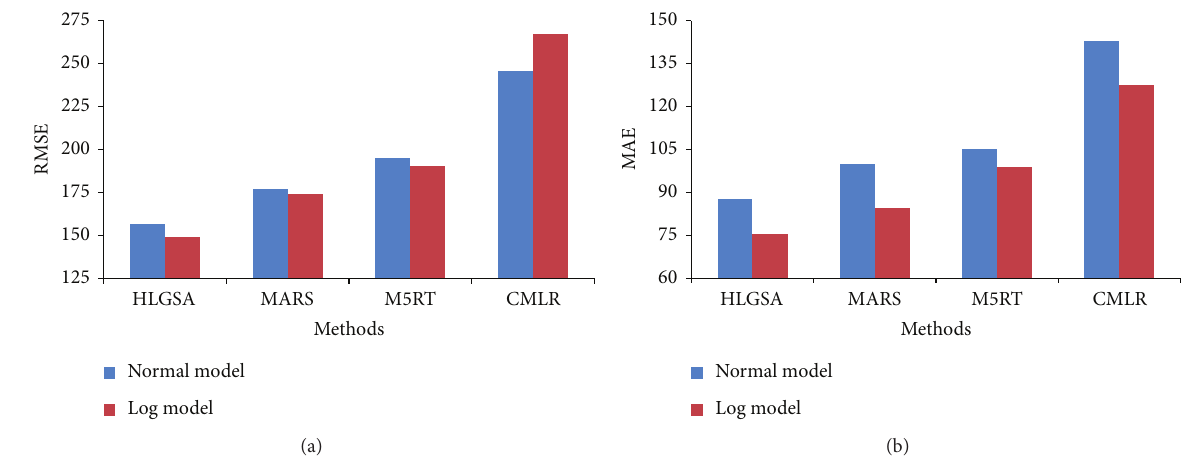
Figure 14: Comparison of overall errors of all log and normal models for Shyok catchment.